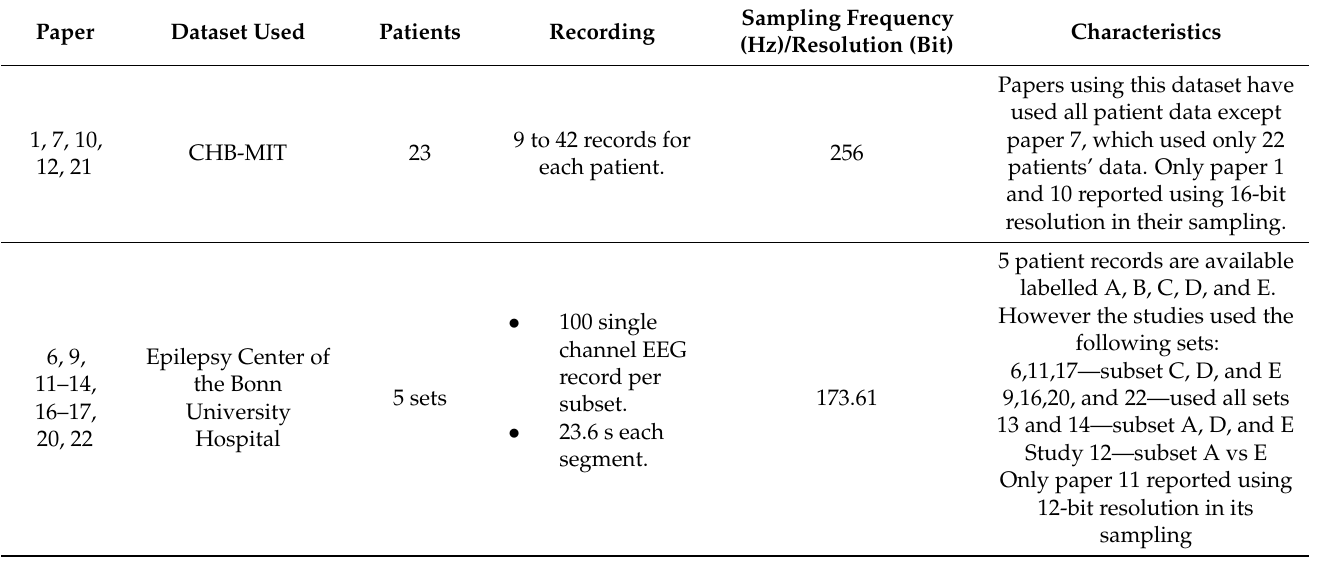
Table A2. EEG databases and EEG recording